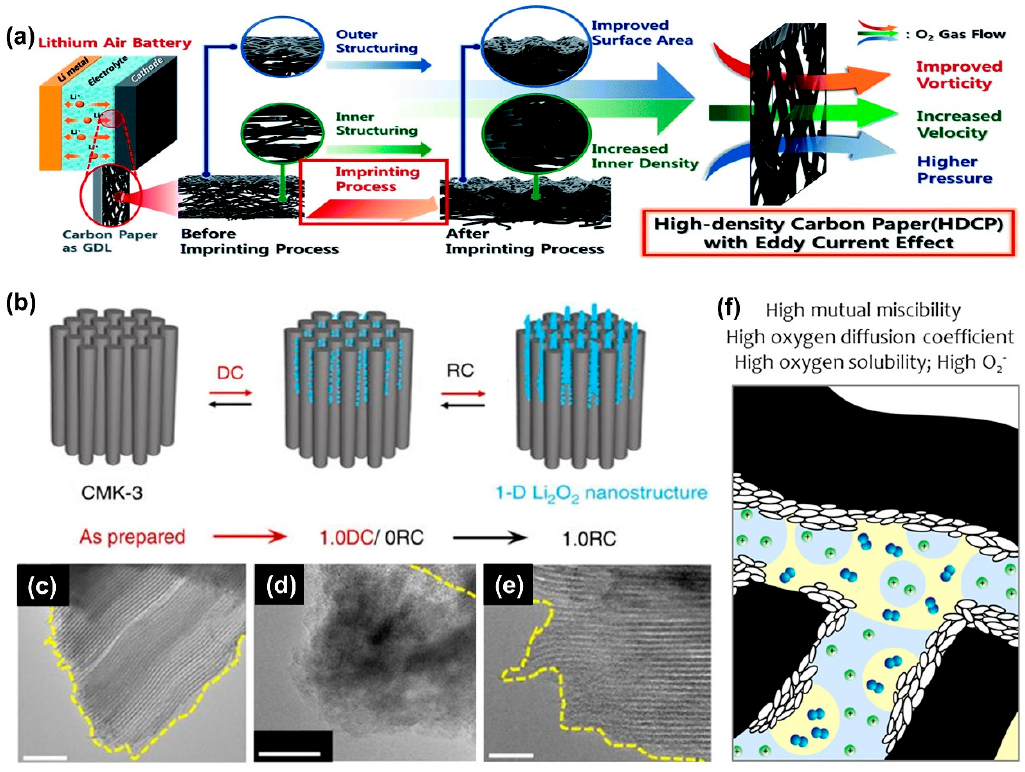
Figure 2. ( a ) Schematic illustration of the high-density carbon paper. ( b ) Schematic illustration of the growth and decomposition of Li 2 O 2 (blue) induced by CMK-3. TEM images of ( c ) as-prepared, ( d ) fully discharged (marked as 1.0 DC or 0 RC), and ( e ) fully recharged (marked as 1.0 RC) CMK-3 electrodes. The scale bars are 50 nm. The corresponding capacity and current density are 1.0 mAh and 50 mA · g − 1 carbon , respectively. The yellow dashed lines indicate the surface of CMK-3. ( f ) Schematic illustration of high mutual miscibility of PFCs (yellow) and electrolyte (blue). ( a ) Reproduced with permission from Ref. [44], copyright 2018, The Royal Society of Chemistry. ( b – e ) Reproduced with permission from Ref. [55], copyright 2018, Nature Publishing Group. ( f ) Reproduced with permission from Ref. [61], copyright 2018, Elsevier.